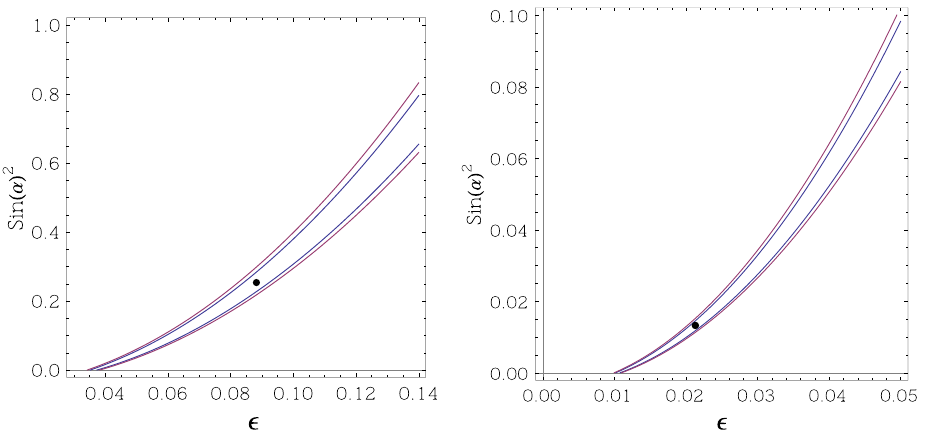
Fig. 2 Allowed regions in the sin (α) – (cid:20) plane, at 90%CL (blue) and 95% CL (red) for degenerate (left) and inverted (right) hierarchy. In this case the θ ν parameter is fixed to the solar angle, and m 0 , 3 is marginalized